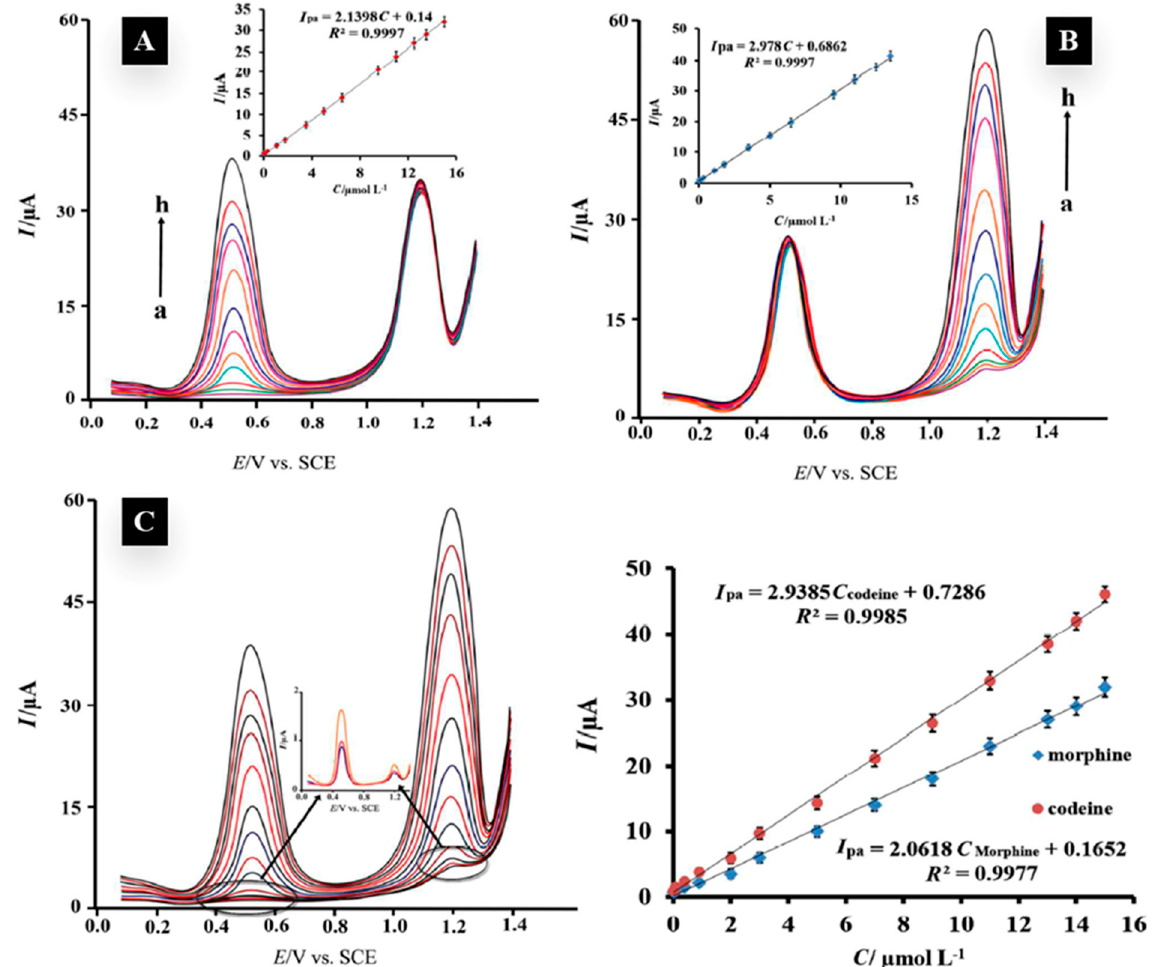
Figure 2. ( A ) DP voltammograms for morphine at the Zn 2 SnO 4 -GO/CPE in the presence of 10 μ mol L-1 codeine in buffer solution (pH = 7.0); pulse amplitude = 50 mV and pulse time = 50 ms. ( B ) DP voltammograms for codeine at the Zn 2 SnO 4 -GO/CPE in the presence of 10 μ mol L-1 morphine. ( C ) DP voltammograms for different concentrations of morphine and codeine in pH 7.0 B-R buffer solution. Adapted with permission from ref. [38] . Copyright 2016 RSC.